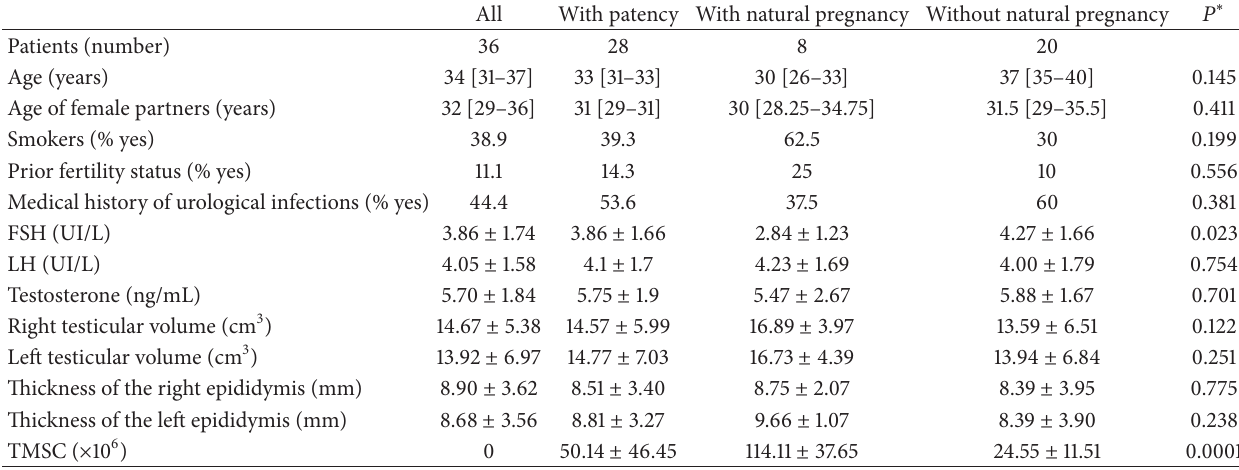
Table 1: Investigated parameters in study